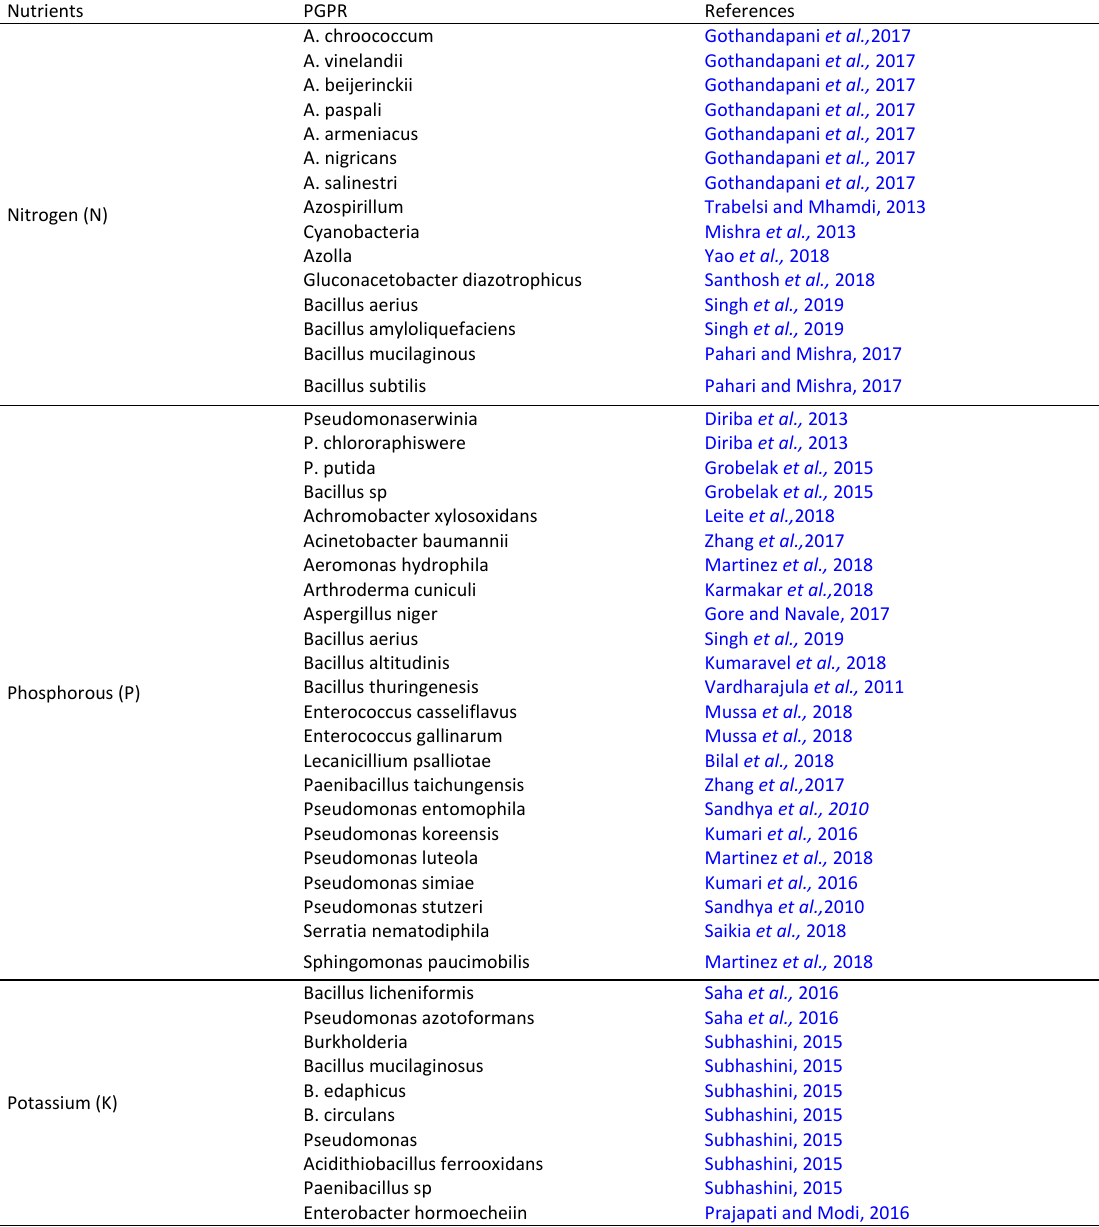
Table 1: Plant nutrients and its corresponding PGPR bacterial strains